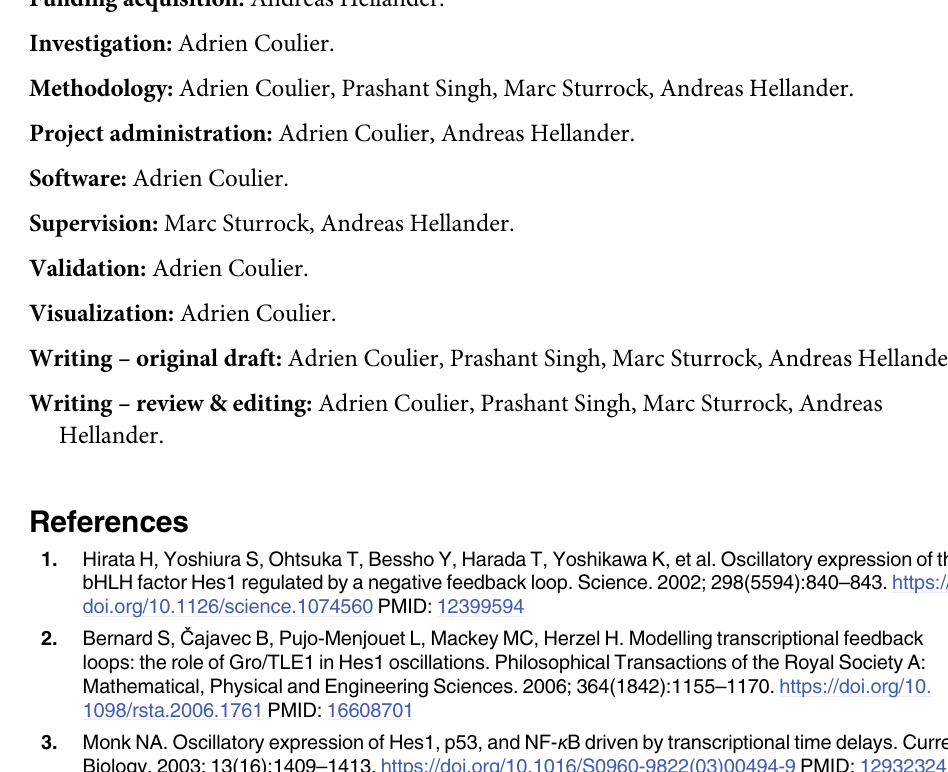
S5 Fig. Boxen plots showing a comparison of expected log-error for all three models using summary statistics (top row) or the Kolmogorov distance (bottow row) with either 64 sim- ulated trajectories (dark blue) or 4 simulated trajectories (light blue). In general, increasing the granularity of the data has a greater effect when using the Kolmogorov distance, where the accuracy improves for both the CBM and Smoldyn. S6 Fig. The data from Fig 4 in the main manuscript plotted with Root Mean Squared Error (RMSE) instead of the expected log-error metric. While there are quantitative differences, the same general trend persists. S1 Text. Summary statistic definitions. Explanation of each of the summary statistics used.